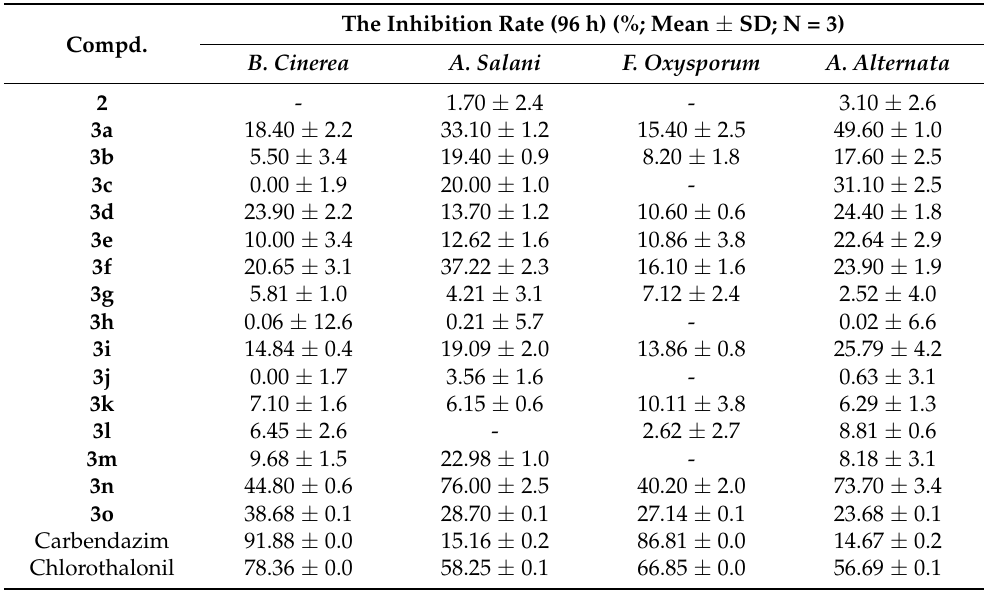
Table 1. Antifungal activity of synthesized compounds without 8-methyl at 200 µ g/mL in 96 h. Compd.